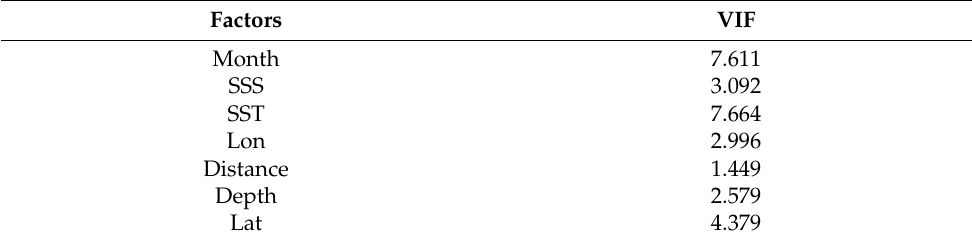
Table 2. Variation inflation factor (VIF)